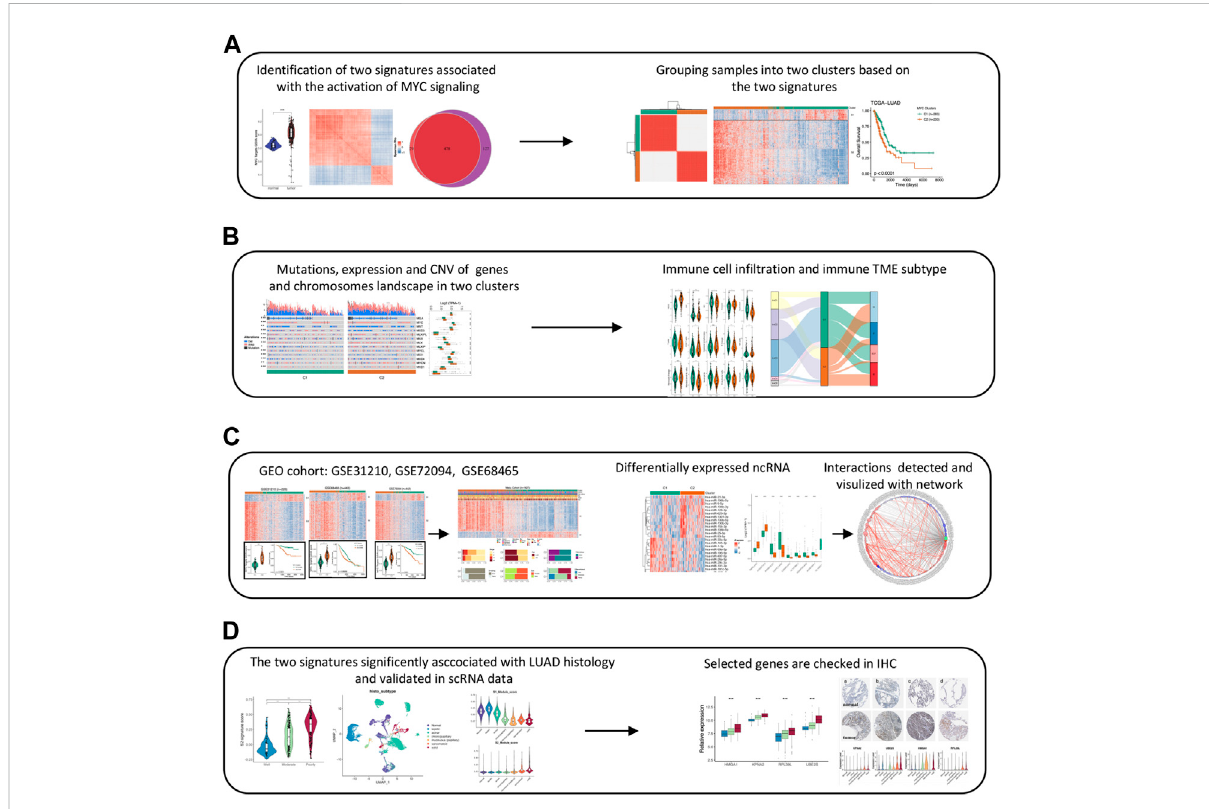
FIGURE 1 The work fl ow chart of this study. (A) Identifying MYC signaling related genes and clustering LUAD samples. (B) Analyzing the differences in multiple levels (Genome, transcriptome, andimmunein fi ltration)betweentwoclusters. (C) Validating therobustness of thetwoMYC signatures and constructing the network of differentially expressed lncRNAs and miRNAs. (D) Verifying signatures association with LUAD cell differention in scRNAseq data and